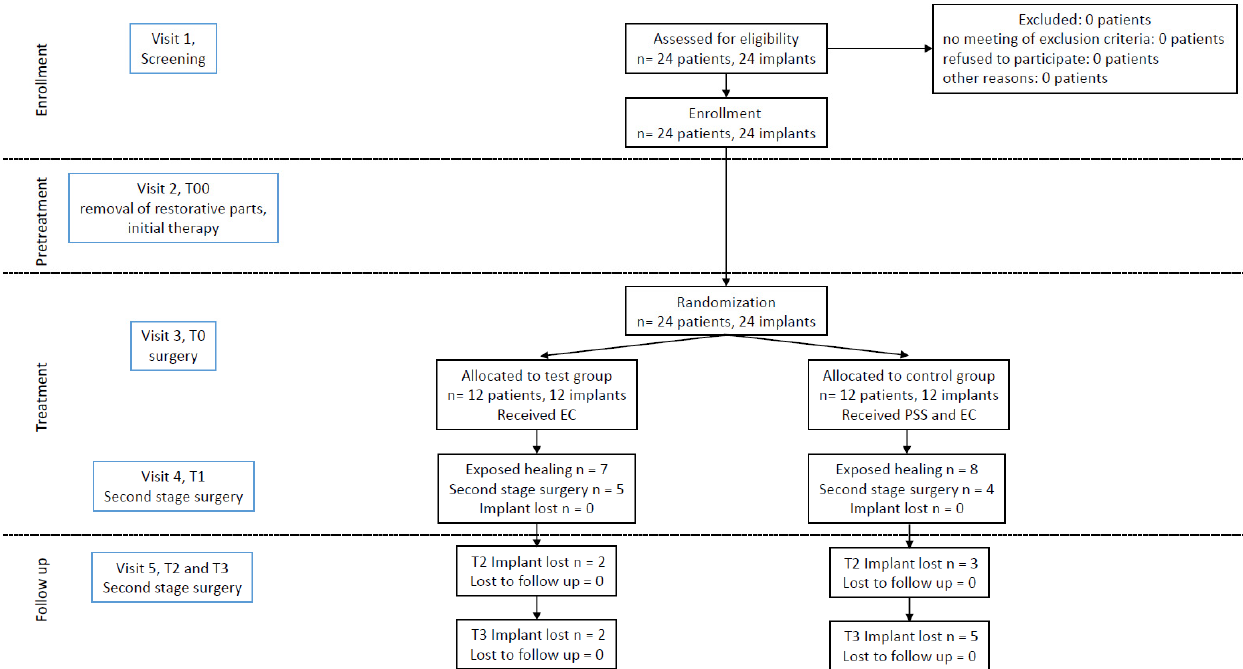
Figure 1. Consort flow chart of the study. The correlation between the assessments of the two investigators of the radiographs was almost perfect (R = 0.999, p < 0.001 (Spearman), p = 0.781 (Wilcoxon)). Figure 2 shows the Bland-Altman plot.